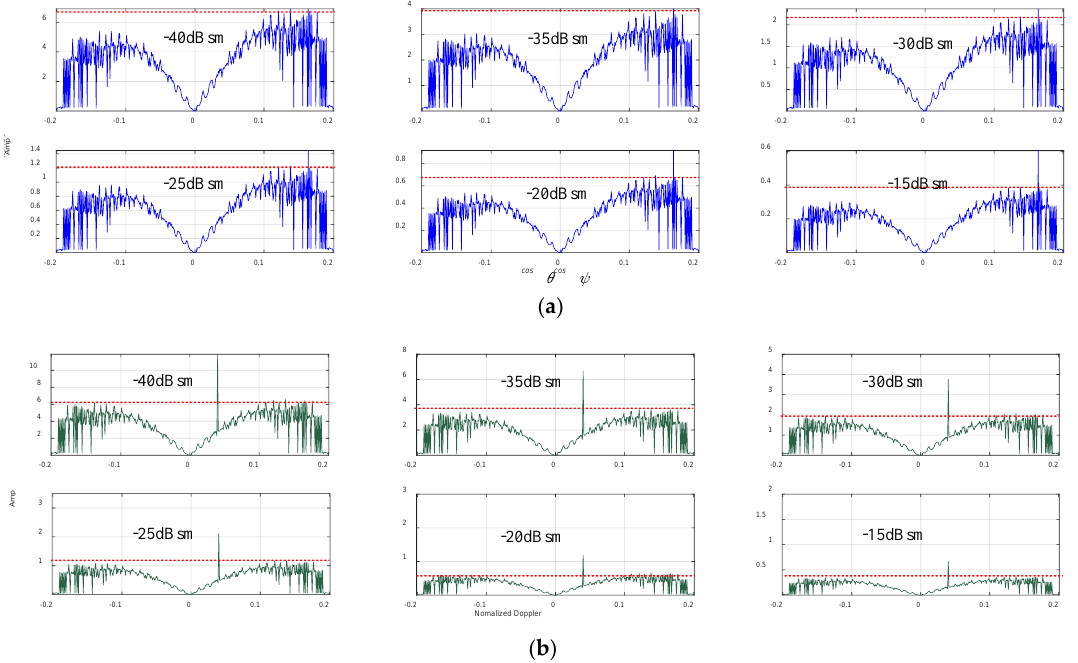
Figure 11. Six object detections by LCMV filtering in (a) azimuth; (b) doppler under − 60dBm noise environment.